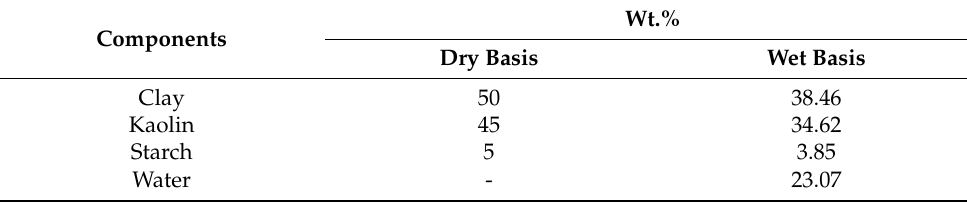
Table 1. Composition of the CMs. Components